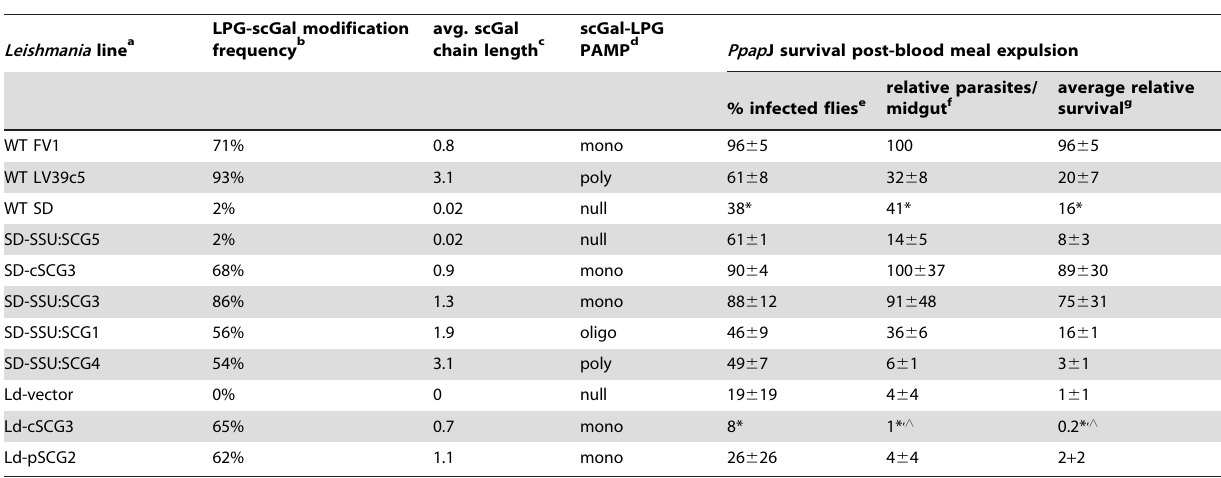
Table 1. Effect of LPG galactosylation pattern on Leishmania survival in ‘‘selective’’ Phlebotomus papatasi PpapJ sand flies.